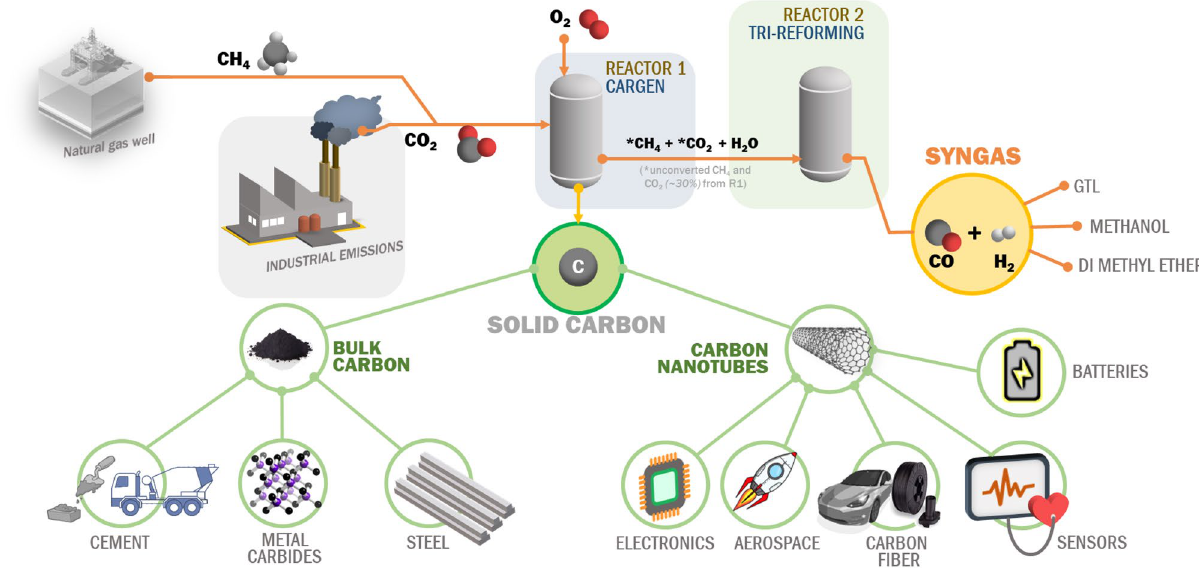
Figure 1. A systematic overview of the novel two-reactor technology with potential applications of the products